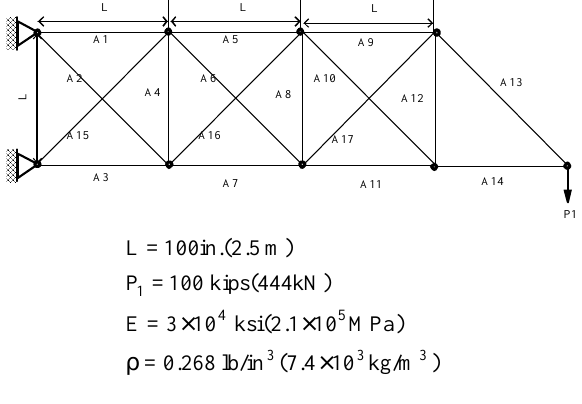
Fig. 3. Seventeen-bar truss structure